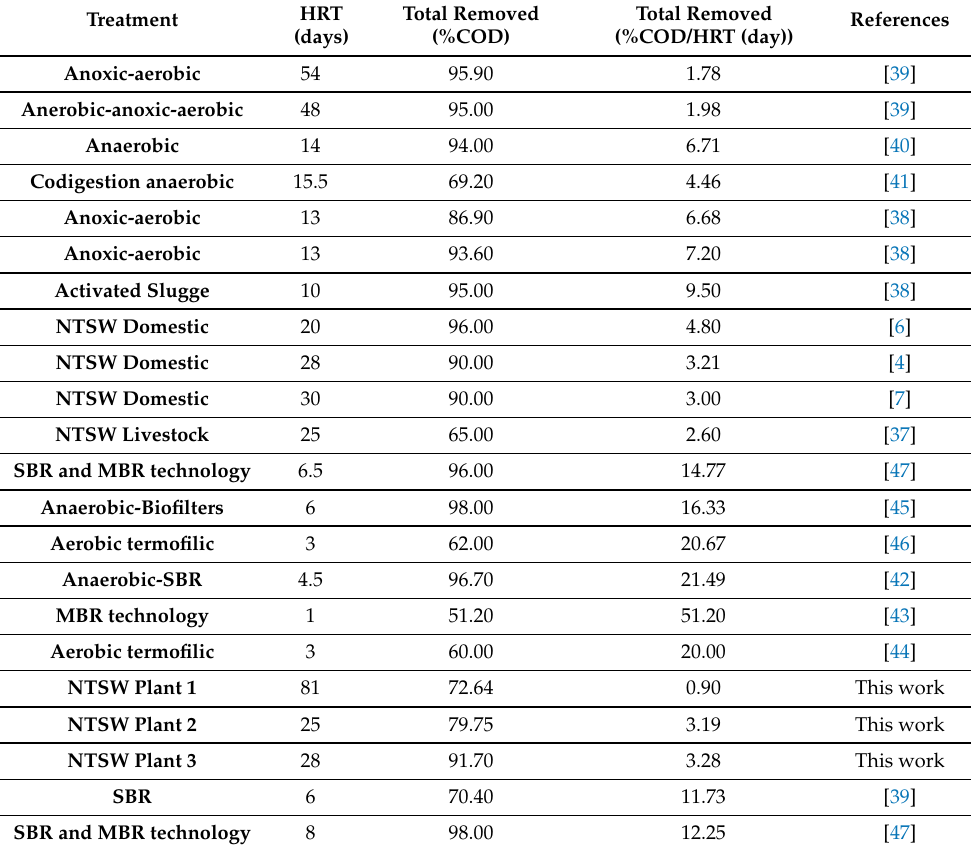
Table 5. Comparison between natural treatment